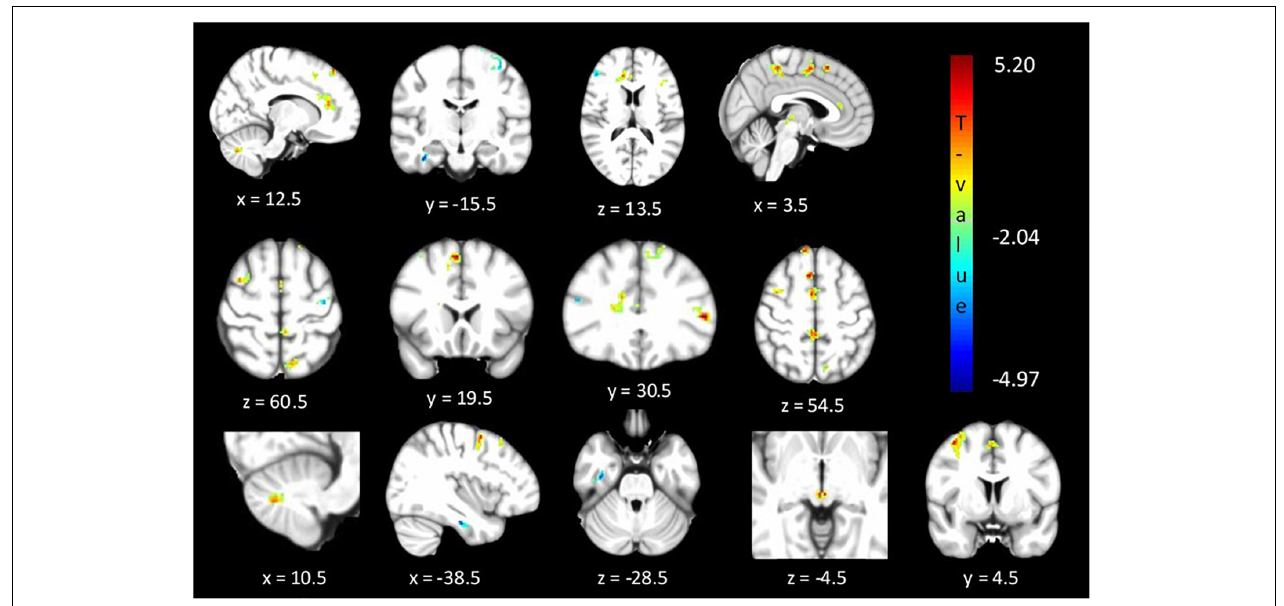
FIGURE 3 | Significant differences (corrected p < 0.05) in ReHo values between relatives with normal vs. abnormal TDT values. The blue/green colors represent regions where Relatives abnormalTDT have decreased local coherence than Relatives normalTDT . The red/yellow colors represent regions where Relatives abnormalTDT have increased local coherence than Relatives normalTDT